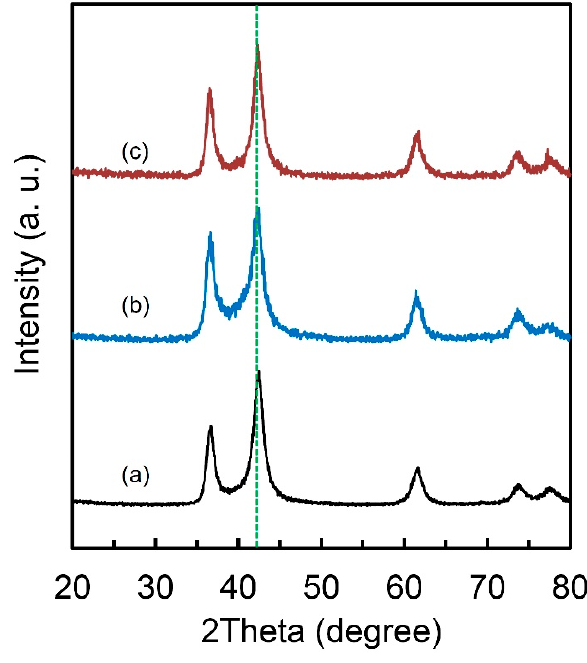
Figure 5. X-ray diffraction curves of ( a ) Ti 50 V 50 -10 wt.% C alloy; ( b ) Ti 50 V 50 -10 wt.% C alloy after PCT measurement and ( c ) Ti 50 V 50 -10 wt.% C alloy after DSC measurement in 1 MPa hydrogen.